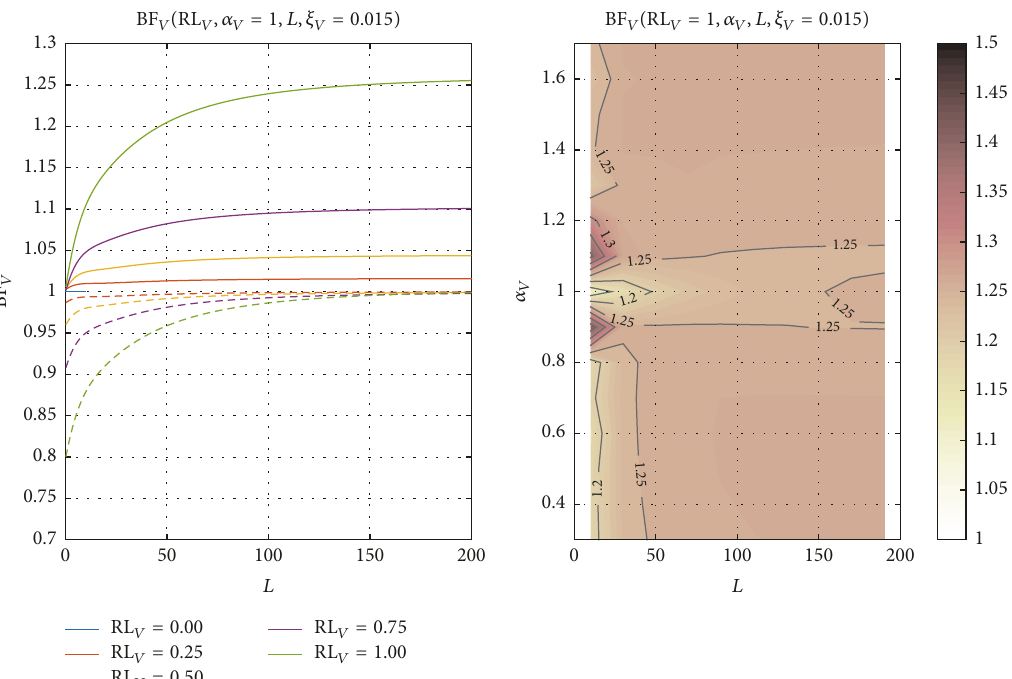
Figure 6: Boundary factor BF 𝑉 ( RL 𝑉 , 𝛼 𝑉 = 1, 𝐿,𝜉 𝑉 = 0.015) (solid lines) and TFRF boundary factor BF 𝜑,𝑉 ( RL 𝑉 , 𝛼 𝑉 = 1,𝐿, 𝜉 𝑉 = 0.015) (dashed lines) for different values of RL 𝑉 evaluated using the solution of Piccardo and Tubino [76]. BF 𝑉 ( RL 𝑉 = 1,𝛼 𝑉 ,𝐿,𝜉 𝑉 = 0.015) evaluated numerically using the solution of Abu-Hilal and Mohsen